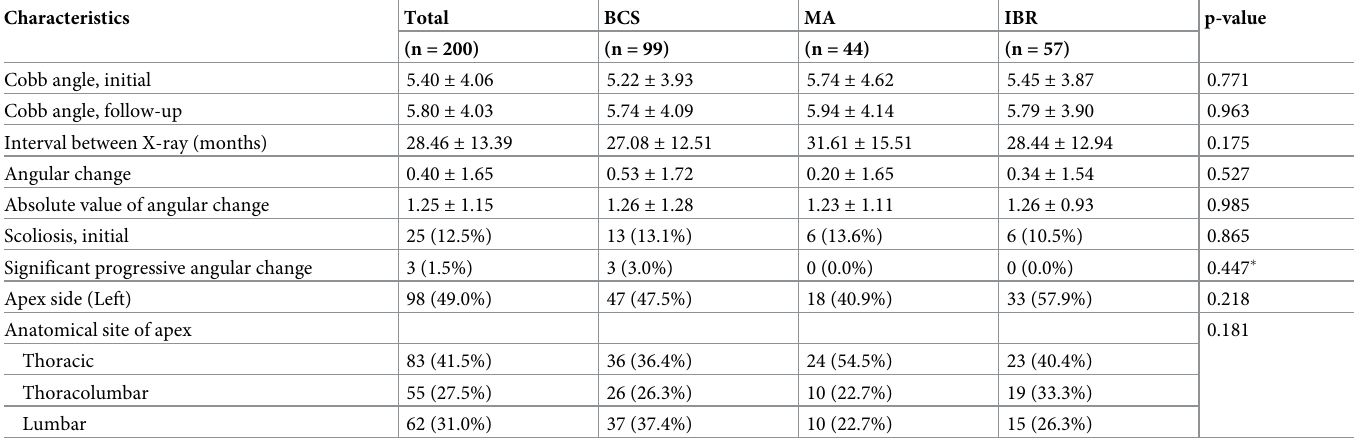
Table 2. Spinal alignment in breast cancer